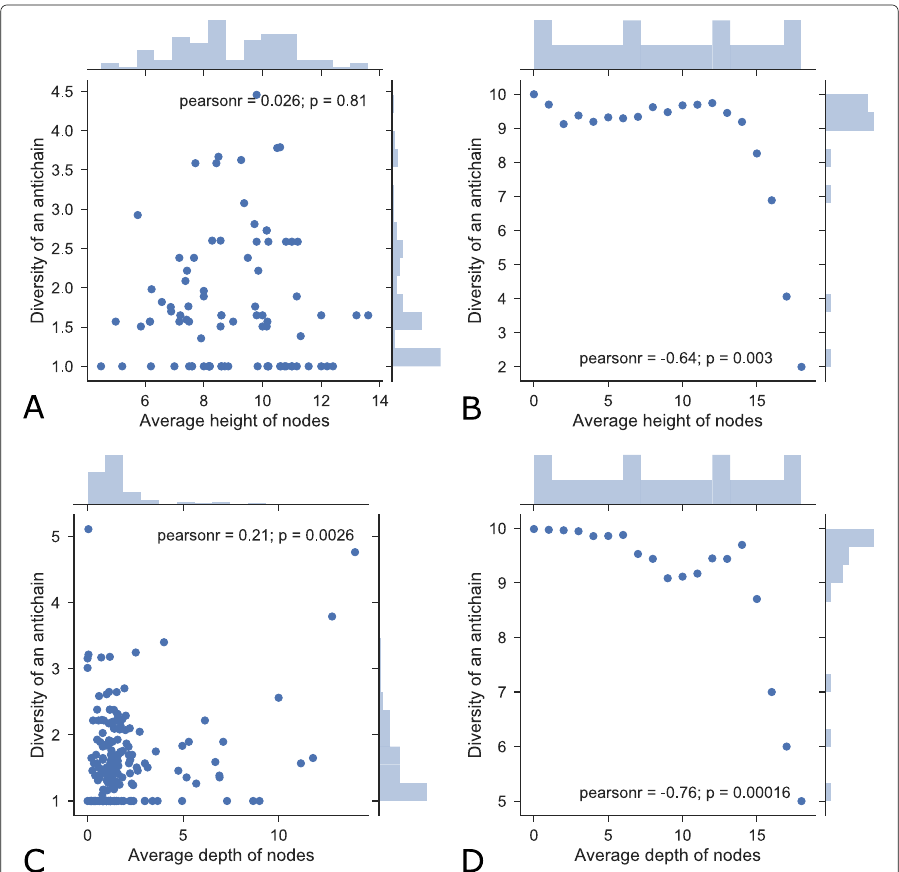
Fig. 5 Shannon’s diversity of antichains in a Price model with planned partition of nodes into five fields for networks of 5,000 nodes. Each node is assigned to a field sequentially and nine times out of ten a new node chooses to connect to an existing node of the same field, with a preference for large degree nodes, φ = 0.9. Each new node attaches to m = 3 older nodes. Each point represents an antichain in a given partition, with the average height or depth of nodes in the antichain and Diversity. Four different types of antichain partition are shown: a - successors-based siblinarity antichains, b - height-based antichains, c - predecessors-based siblinarity antichains, d - depth-based antichains. The height and depth antichains are clearly much bigger (few points on their plots) but much less diverse, with their diversity close to the theoretical maximum 10.0. On the other hand, the siblinarity antichains based on co-citation similarity ( a ) or bibliometric coupling ( b ) are drawn largely from the same field with diversities close to the minimum value of